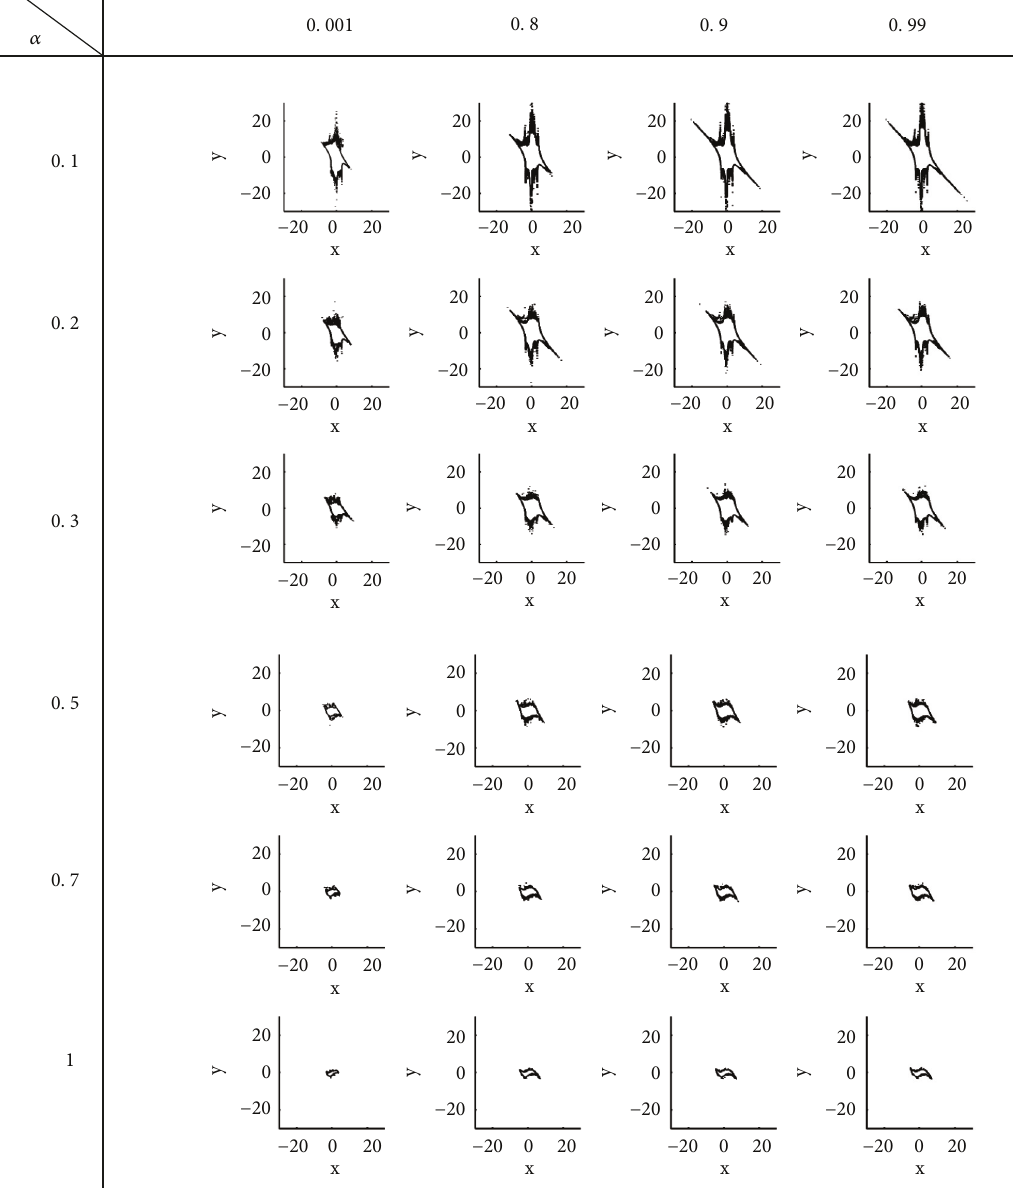
Figure 4: The change of Julia sets of the controlled system (17) when ( a ) 𝛼 = 0.1; ( b ) 𝛼 = 0.2; ( c ) 𝛼 = 0.3; ( d ) 𝛼 = 0.5; ( e ) 𝛼 = 0.7; ( f ) 𝛼 = 1 and 𝜇 = 0.001, 0.8, 0.9, 0.99